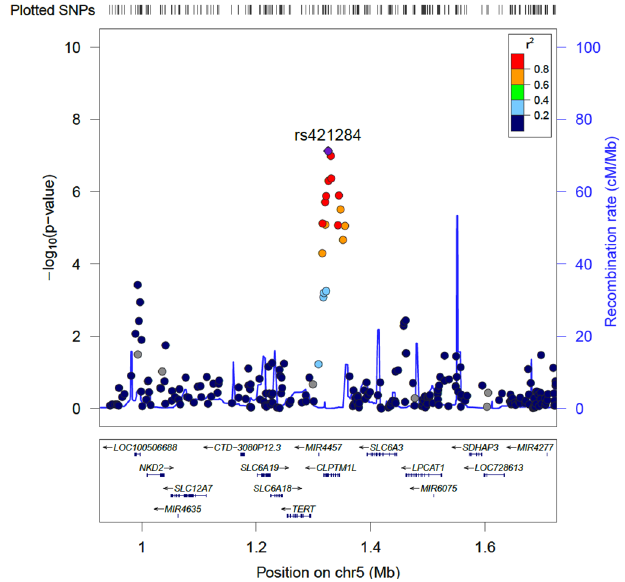
Fig. 2 Regional linkage disequilibrium plot for 5p15.33. Genes are depicted with blue arrows showing transcription orientation and SNPs appear in colored dots . The color intensity of dots re fl ects the level of linkage disequilibrium with the highlighted SNP of interest (shown with a purple diamond ). The blue line indicates recombination rates in the CEU population. Linkage disequilibrium ( r 2 )